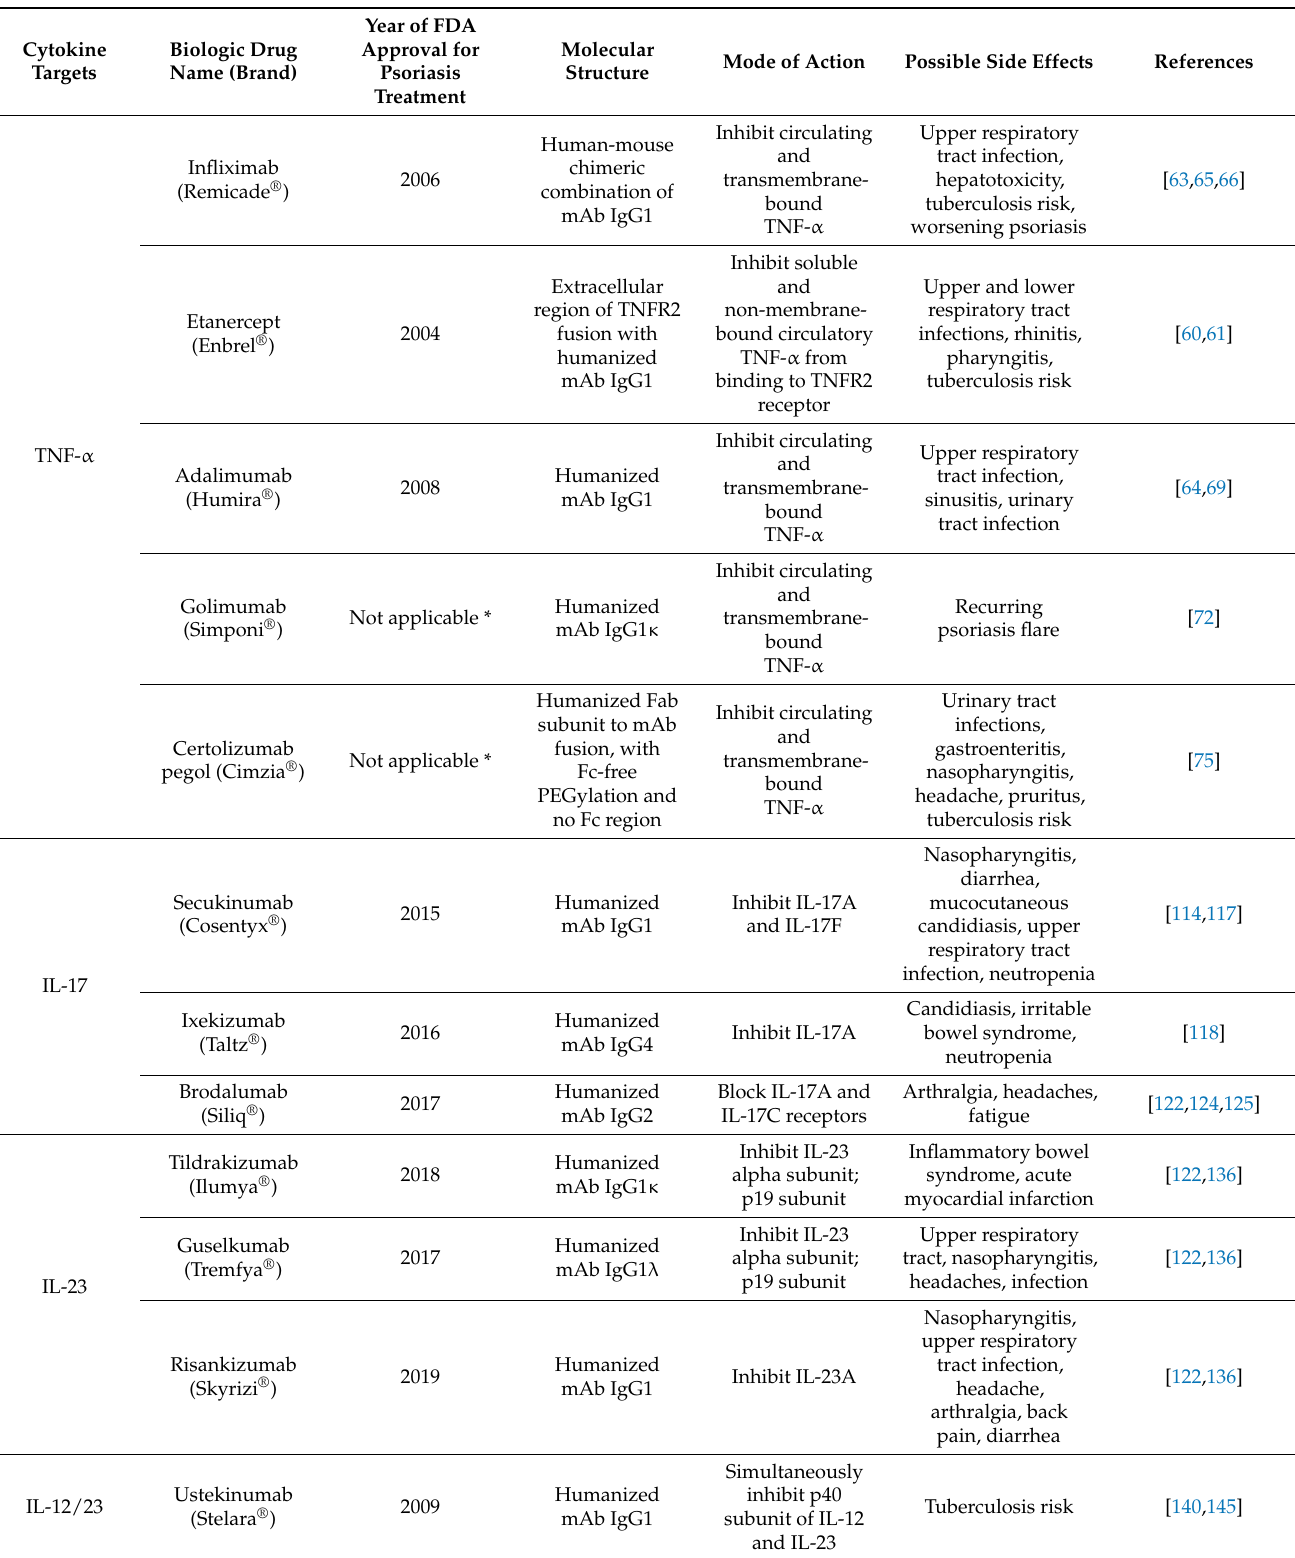
Table 1. Summary of cytokine inhibitors used in psoriasis